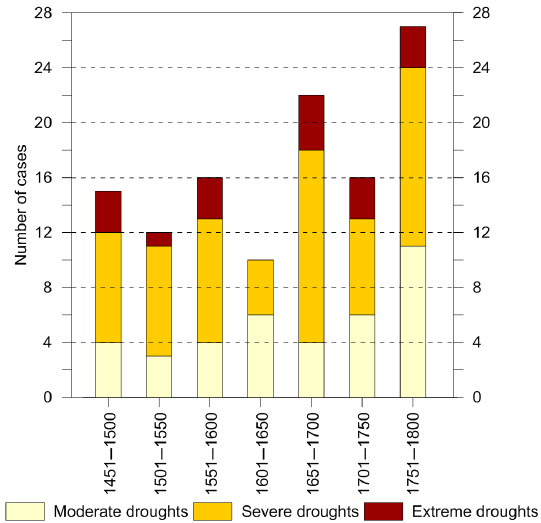
Figure 5. Frequency of occurrence of three categories of droughts in Poland in 50-year periods,